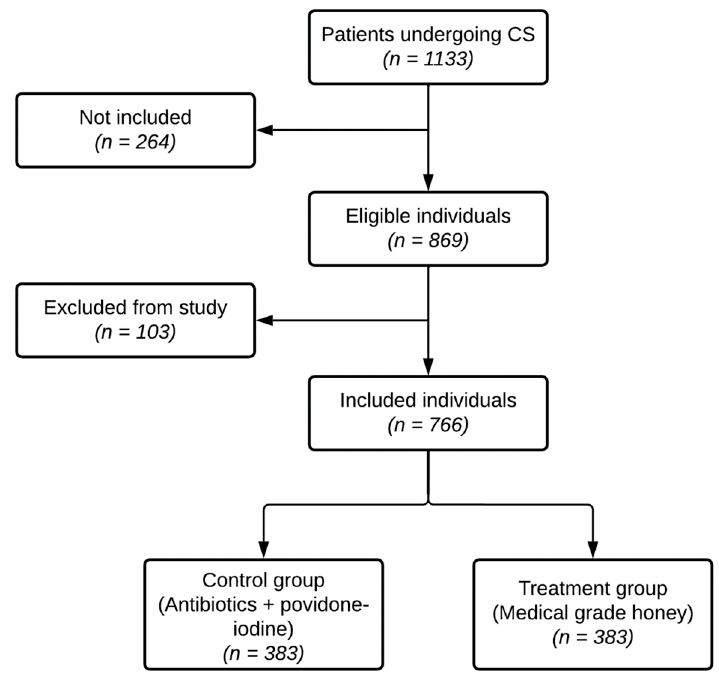
Figure 3. Flow diagram for inclusion and exclusion of patients.